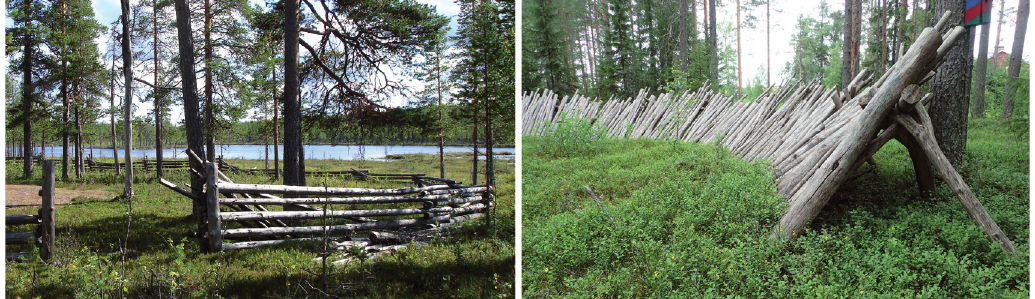
Figure 11. The two fence types formerly known to have existed in Arjeplog Municipality before the arrival of the North Sami: the log fence (left) and the palisade fence (right). Both fences are reconstructions, the log fence by Lake Sundtjärnen, Malå Municipality, and the palisade fence in Raamesuenne cultural center, Vindeln Munici-